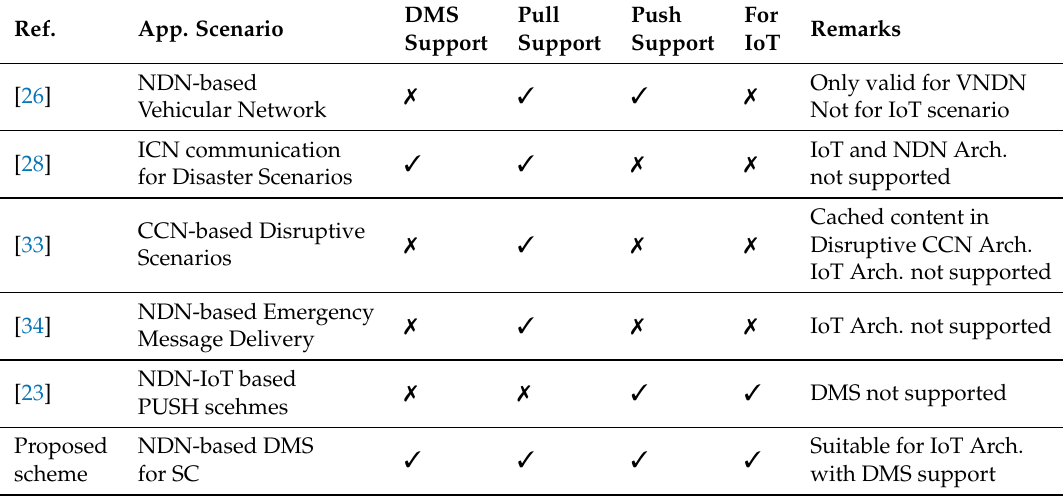
Table 2. Summary of Related Research